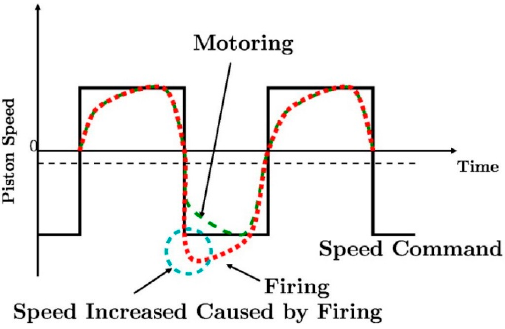
Figure 25. The basic principle diagram of the control method at Toyota Central R&D Labs [1].